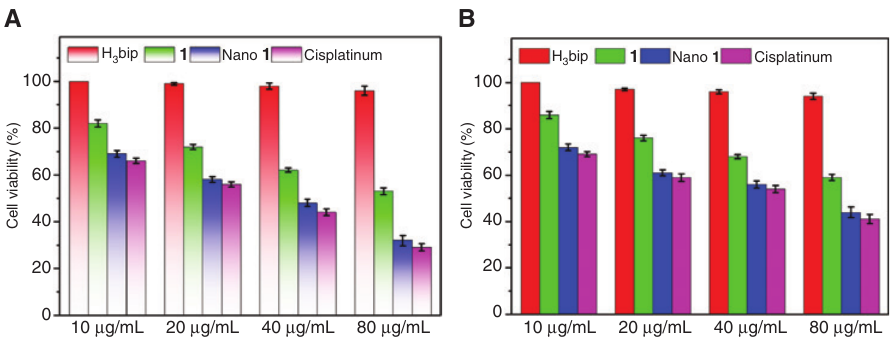
Figure 4: The MTT assay results for 1 . Growth inhibitory effects of the H bip ligand, 1 , and the nanoscale 1 against the (A) A549 and (B) NCI-H1299 cell 3